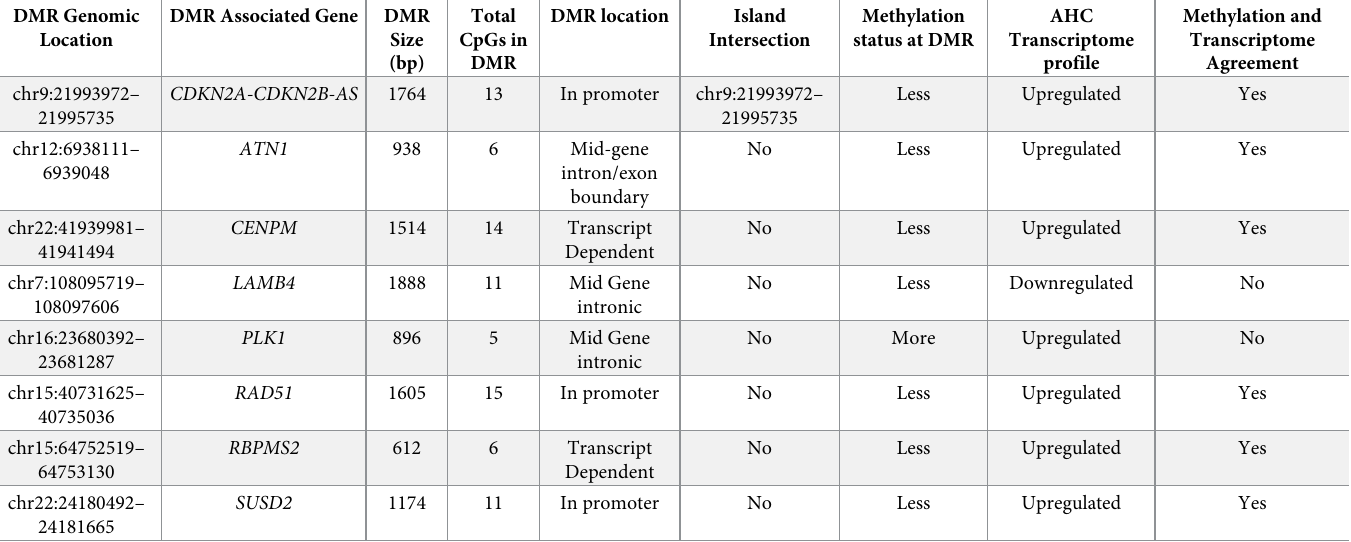
Table 7. DMR characterization and comparison to transcriptome